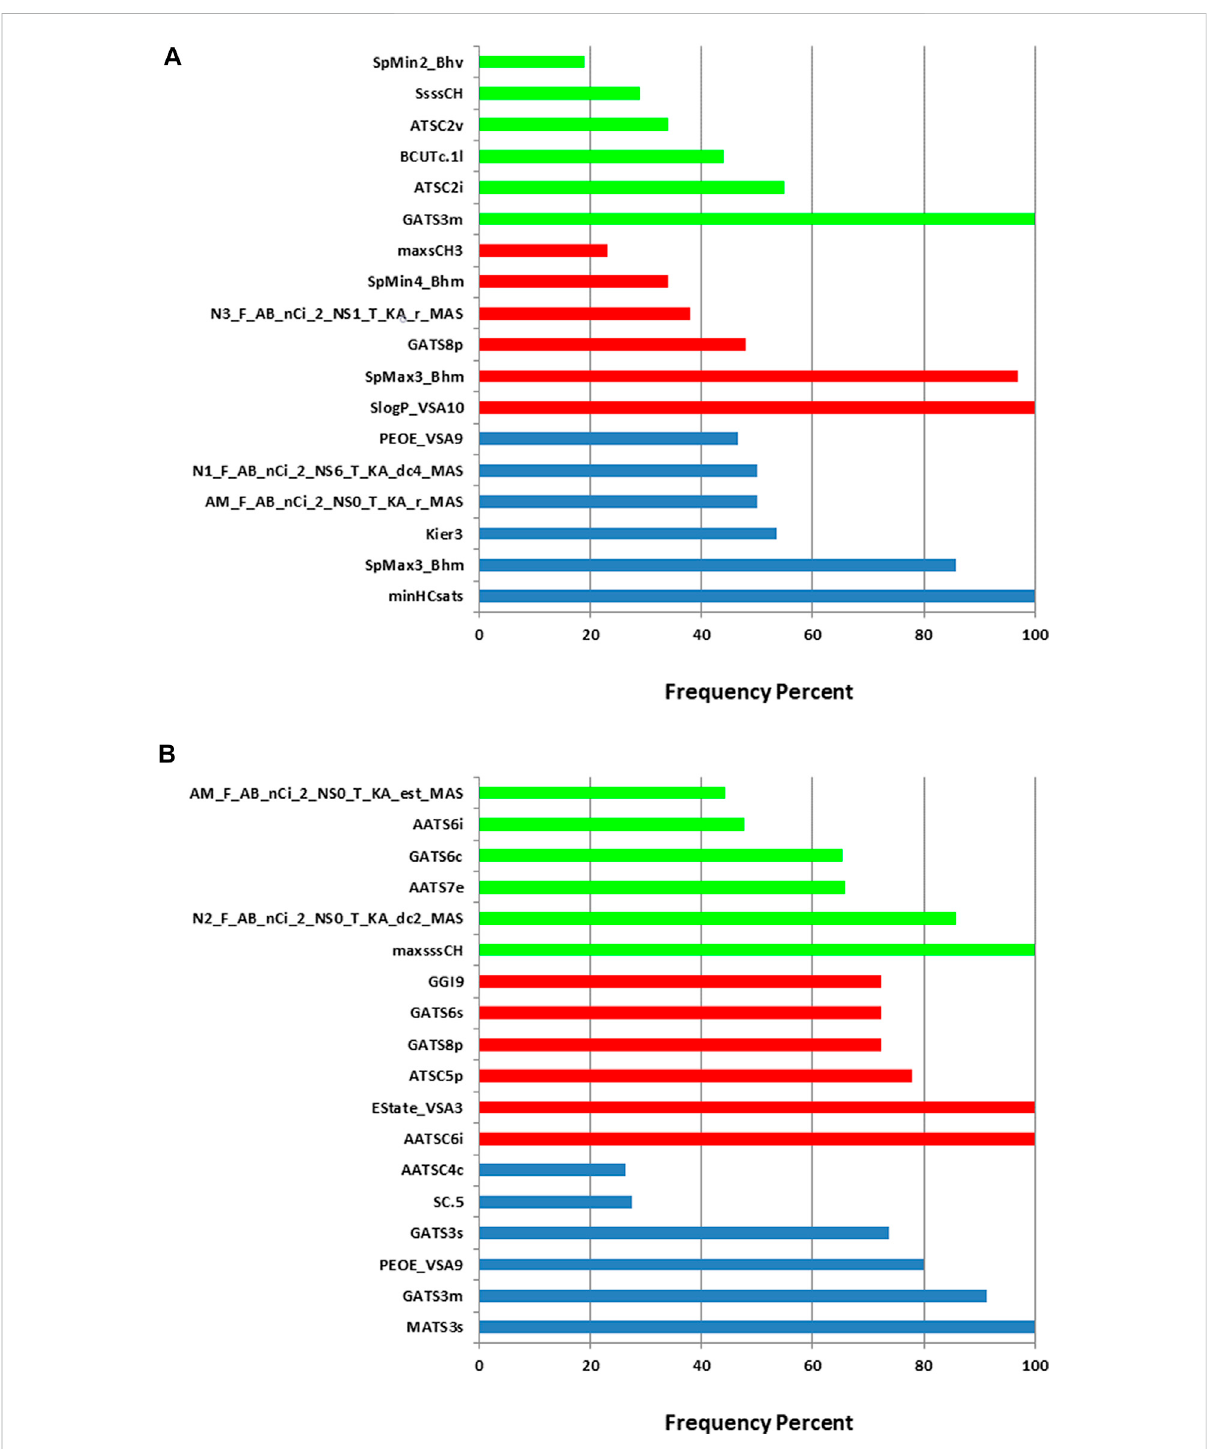
FIGURE 3 Relative frequencies of descriptors in the descriptor combinations selected by the evolutionary algorithm. (A) training set 1. (B) training set 2. Blue: ANN, red: SVM and green: